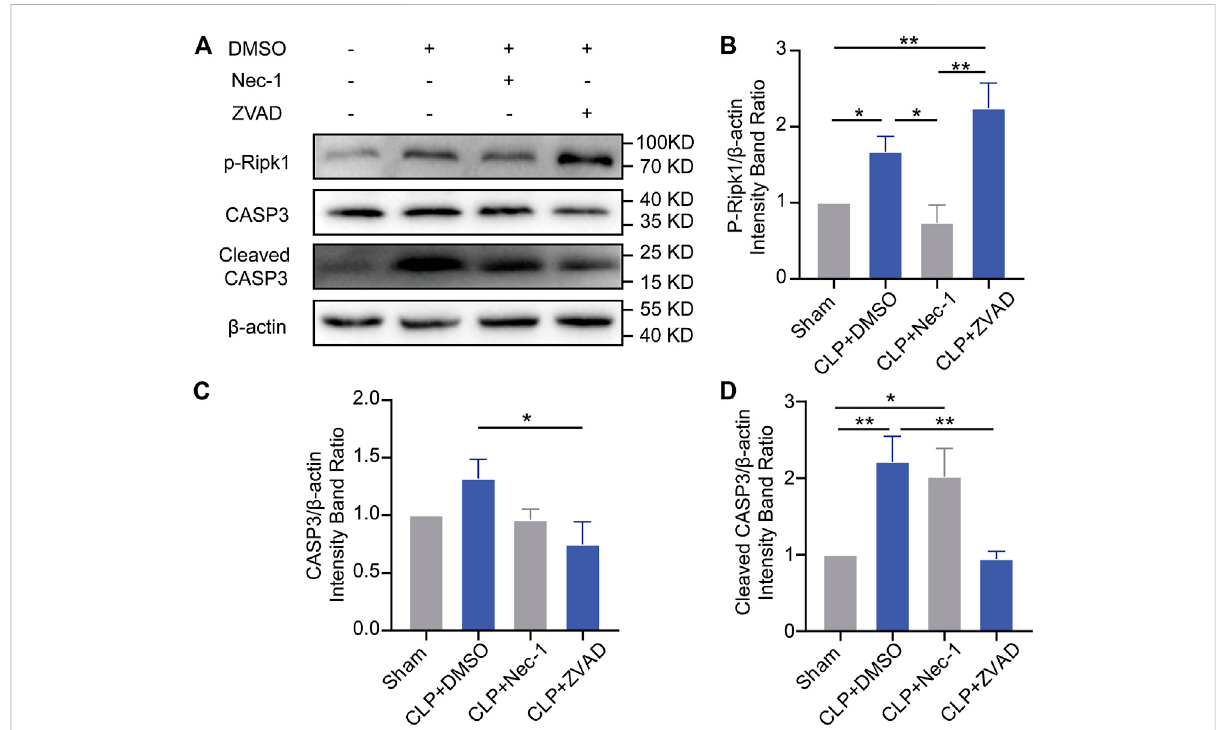
FIGURE 3 Apoptosis and necroptosis showed Ramsay ’ s rule in the brains of septic mice. (A) . Representative Western blots of p-Ripk1, caspase-3 and cleaved caspase-3. (B) . Quantitativeevaluation of p-Ripk1 expression with different treatments. (C) . Quantitativeevaluation of caspase-3 expression with different treatments. (D) . Quantitative evaluation of cleaved caspase-3 expression with different treatments. * p < 0.05, ** p < 0.01. Data are shown as the mean ± SEM ( n =